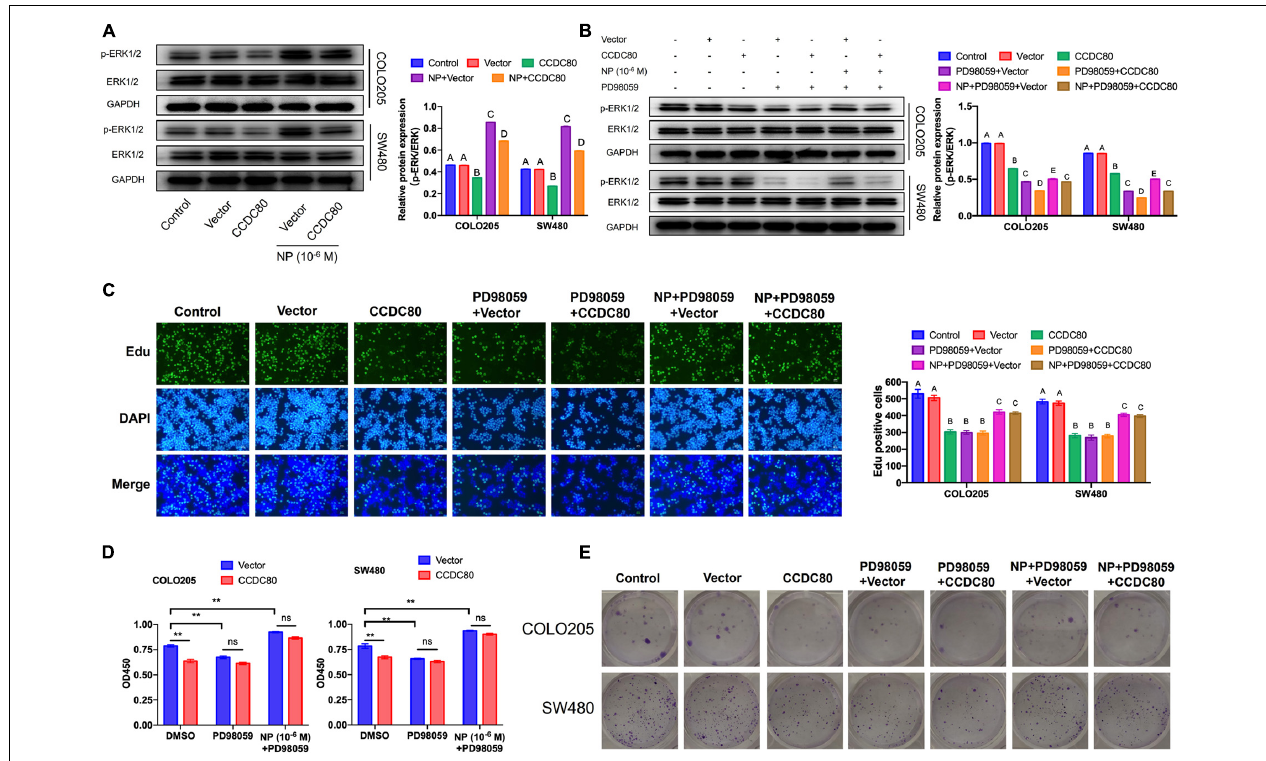
FIGURE 6 | Coiled-coil domain containing 80 (CCDC80) suppresses colorectal cancer (CRC) cell proliferation by inhibiting ERK1/2 activity. (A) Infected COLO205 and SW480 cells were treated with nonylphenol (NP) (10 − 6 M) for 24 h. The expression of ERK1/2 and phosphorylated ERK1/2 (p-ERK1/2) in these treated CRC cells as analyzed using western blot assay. (B) Infected COLO205 and SW480 cells were treated by NP (10 − 6 M) or extracellular regulated protein kinases (ERK) inhibitor PD98059 for 24 h. The expression of ERK1/2 and phosphorylated ERK1/2 (p-ERK1/2) in these cells as analyzed using western blot assay. (C) Treated COLO205 and SW480 cells analyzed using EdU assay. Bar = 100 µ m. Positive cells were measured, and the results are shown as bar charts. (D) The ability of cell proliferation tested using CCK8 assay in treated COLO205 and SW480 cells. ** p < 0.01. (E) Colony forming assay performed to test the growth of treated cells.